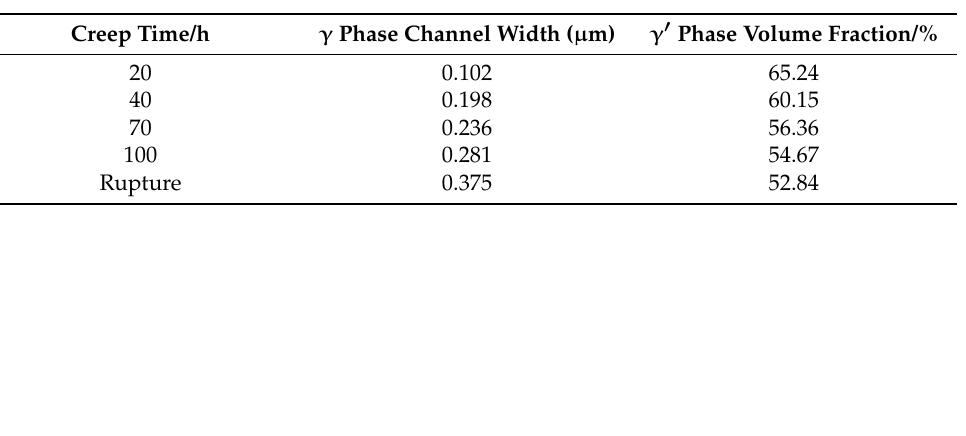
Table 3. Creep interruption test alloy γ (cid:48) phase volume fraction and γ phase channel